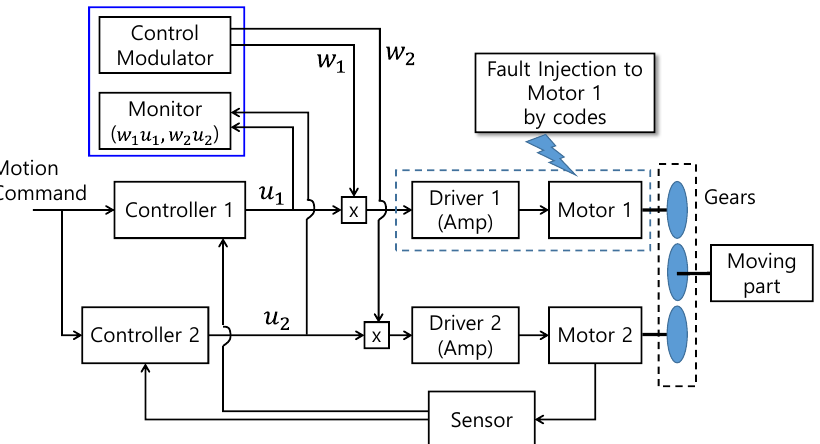
Figure 16. Block diagram of the test bed with the gear mechanism.